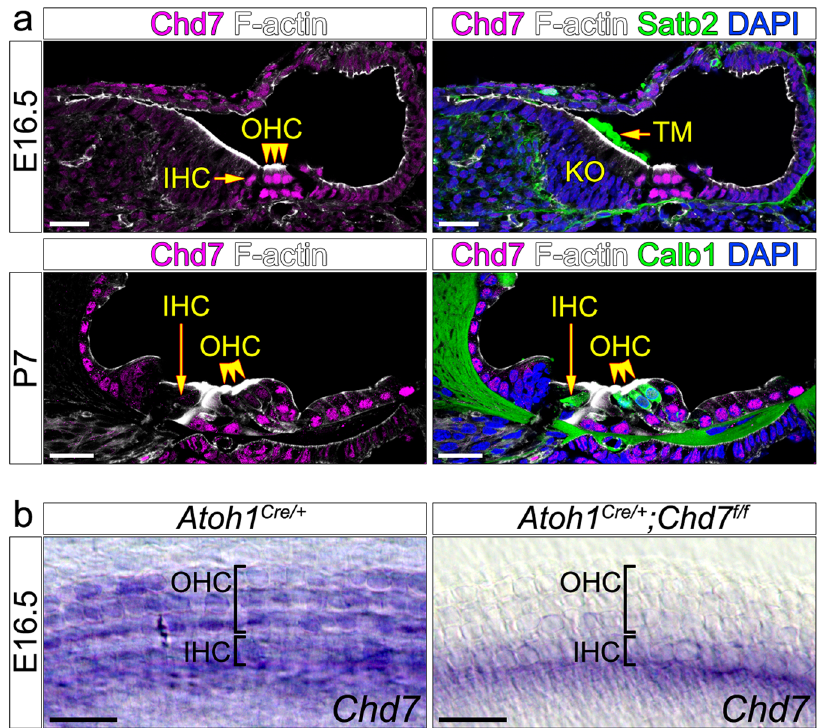
Fig. 1 Chd7 expression in wildtype and Atoh1 Cre/ + ;Chd7 f/f mutant organ of Corti. a Immunohistochemistry in wildtype cochlea showing Chd7 expression in hair cells at E16.5 and P7. Expression is weaker at P7 compared to E16.5. Hair cells are stained with F-actin and Calbindin 1. Tectorial membrane is stained with Satb2. b In-situ hybridisation showing loss of Chd7 expression in Atoh1 Cre/ + ;Chd7 f/f mutant hair cells within the middle region of the cochlea at E16.5. Atoh1 Cre/ + or Chd7 fl oxed siblings were used as controls (indicated at the top of the panel). IHC inner hair cells; OHC outer hair cells; TM tectorial membrane. Scale bars 25 µ